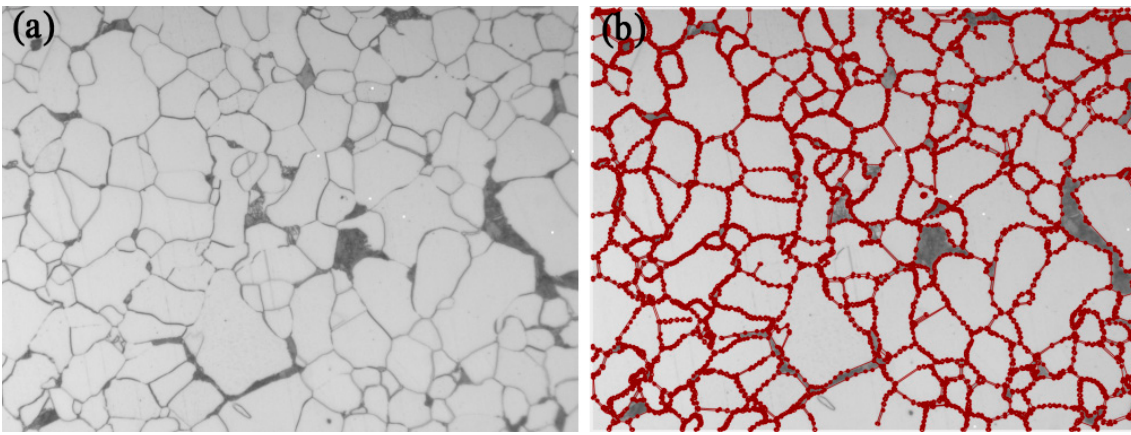
Figure 6. Original image ( a ) and Labeled image ( b ).